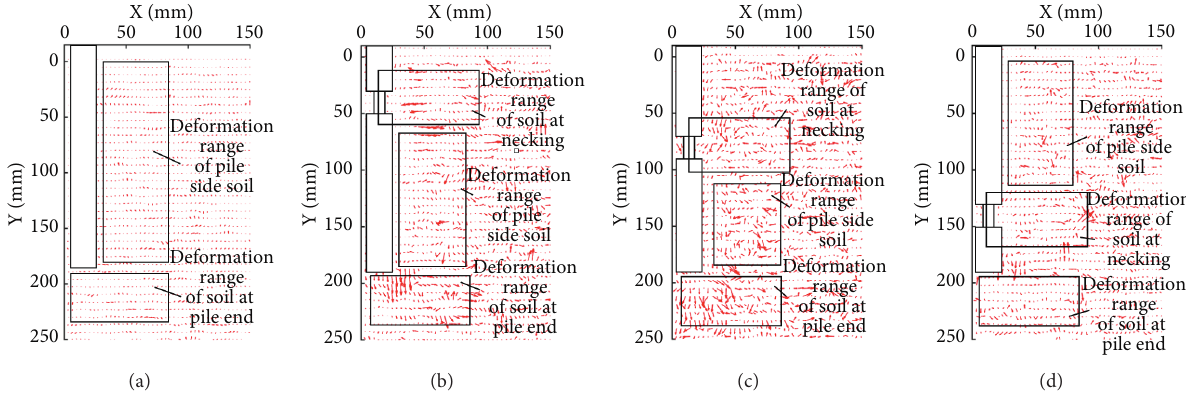
Figure 7: Displacement vector diagram of soil around the single pile under 140N load level. (a) Intact pile. (b) Necking in the shallow pile body. (c) Necking in the middle pile body. (d) Necking in the deep pile body.